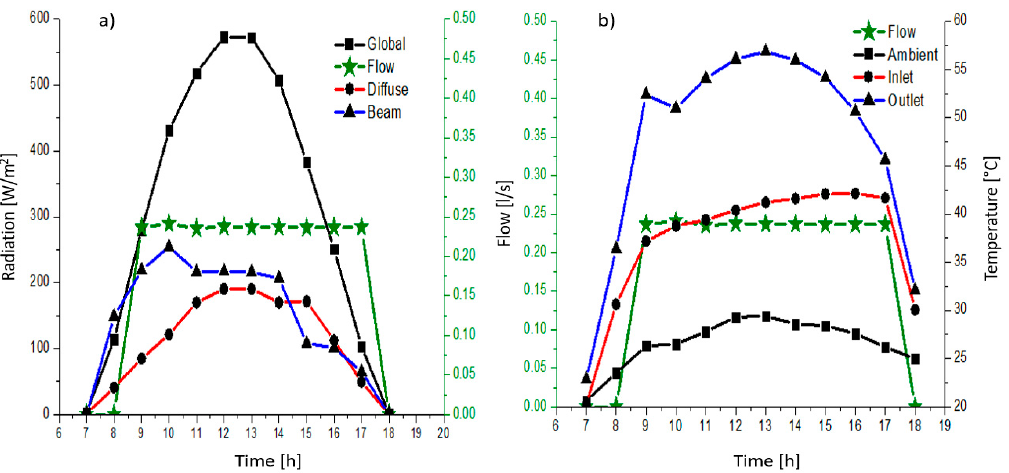
Figure 10. Experimental evaluation of ( a ) Radiation of Merida Yucatan and ( b ) ambient, inlet, and outlet CPC temperatures obtained on the 29 December 2016.